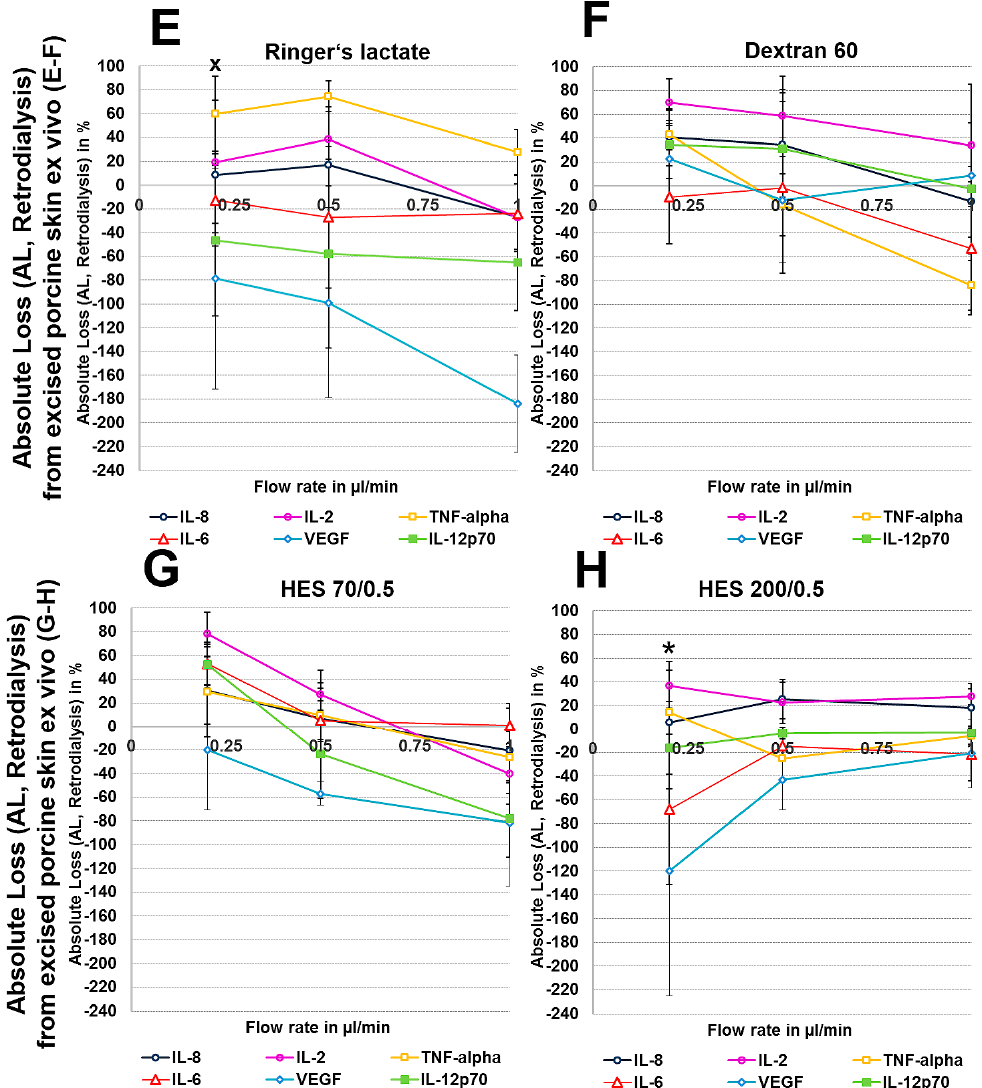
Figure 5. ( A – H ): Effect of different colloid perfusates (dextran 60 ( B , F ), hydroxyethyl starches (HES) 70/0.5 ( C , G ) and 200/0.5 ( D , H ) and the crystalloid Ringer’s lactate solution ( A , E )) on absolute loss (AL) from excised human ( A – D ) and porcine skin ( E – H ) during retrodialysis and ex vivo experiments. Each figure represents the mean values with standard deviation of three independent experiments of all six different cytokines at flow rates of 0.2, 0.5, and 1 µ L/min. Significance ( p < 0.05) is indicated by *, x, o and +. * shows significant differences when compared with Ringer’s lactate, x shows significant differences compared with HES 200/0.5, + shows significant differences compared with HES 70/0.5, and o shows significant differences compared with dextran 60